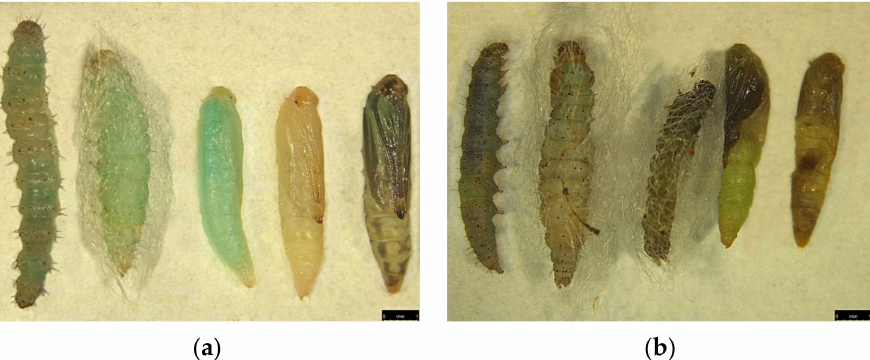
Figure 8. Impact of miR-11912-5p-mimic administration on P. xylostella larval development and pupal formation. ( a ) Larvae showing normal growth leading to successful pre-pupation and pupation in untreated population (left to right); ( b ) abnormal development during larval stage leading to failed pre-pupation and pupation in miR-11912-5p mimic-fed population (Left to Right).